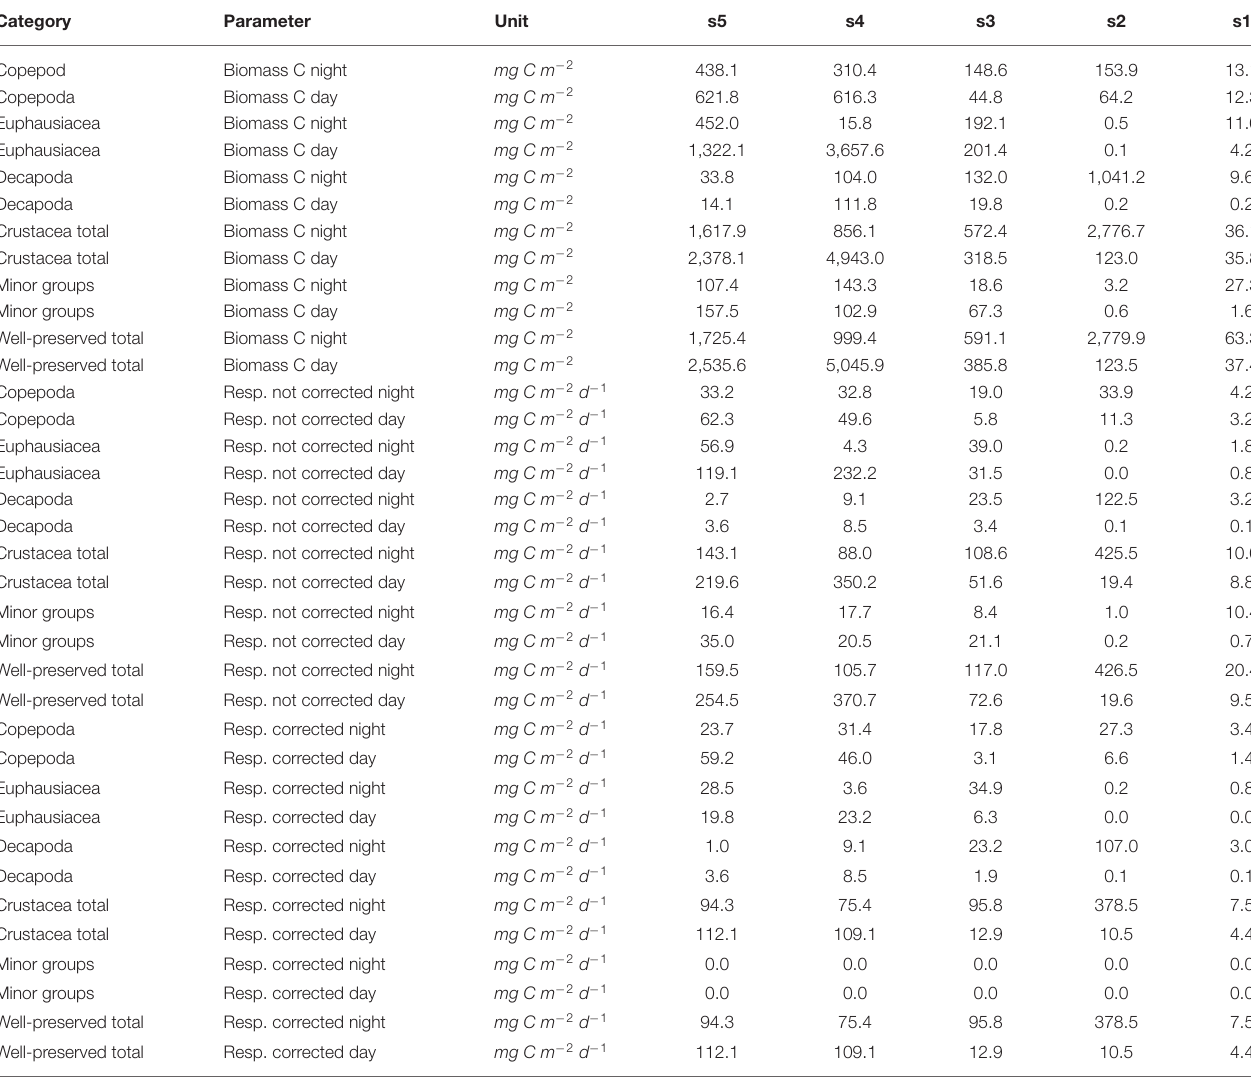
TABLE 3 | Integrated biomass and respiration